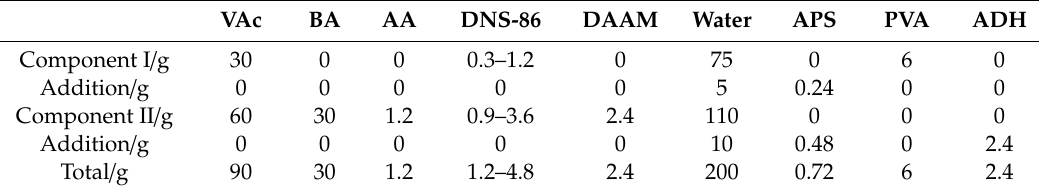
Table 1. Amounts used in the emulsion